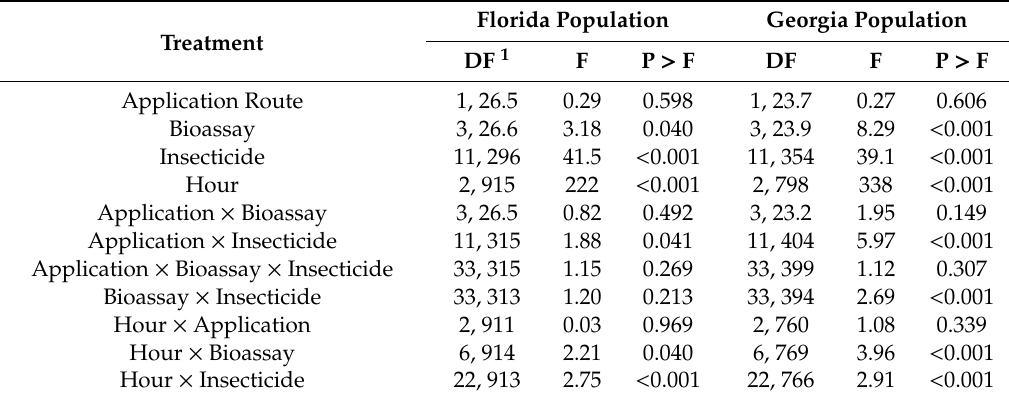
Table 1. E ff ects of treatments and their interactions on adult mortality (percent dead corrected by subtracting dead adults at the time of loading the arenas) for Florida and Georgia whitefly populations, Coastal Plain Exp. Station, Tifton, GA, USA,